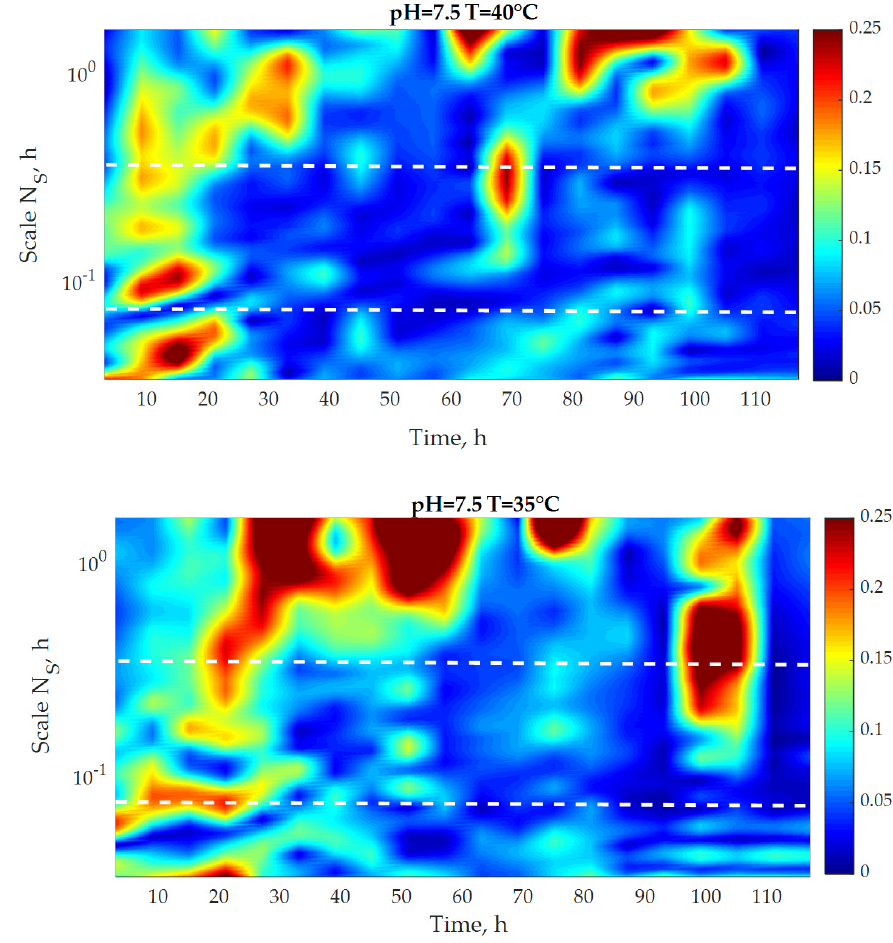
Figure 9. Dynamical multifractal index for two experimental tests.